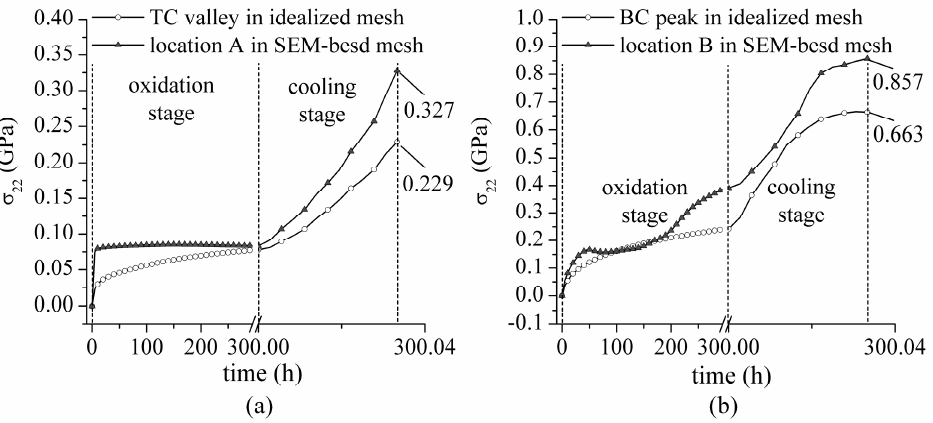
Figure 9. Evolution of maximun σ 22 in ( a ) TC layer and ( b ) BC layer.